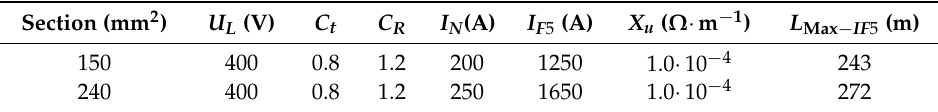
Table 7. Short-circuit conditions. Results of Equation (11).